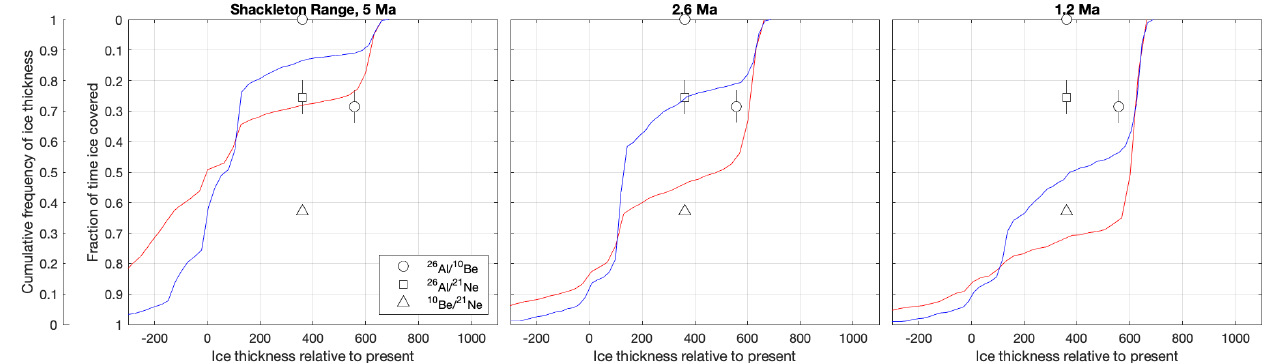
Figure 12. Ice cover frequency estimates for the Shackleton Range inferred from paired 26 Al / 10 Be data and the inversion code of Spector et al. (2020), compared with sensitized and desensitized model CDFs for the same site. The model CDFs are referenced to the ice thickness in the final model time step, and no model–data alignment has been attempted. The data are described in Fogwill et al. (2004), Hein et al. (2011, 2014), and Sugden et al. (2014). Sample elevations relative to the present ice margin are taken directly from the source publications without additional examination.